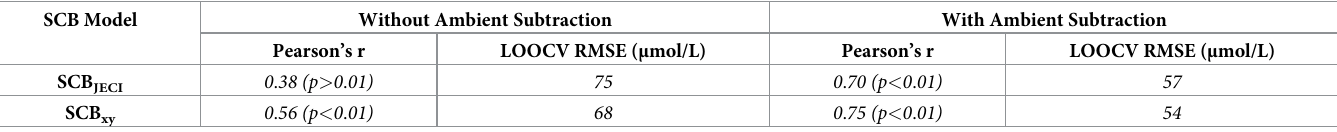
Table 1. Comparison of SCB models in terms of correlation with TSB and RMSE with/without ambient subtraction. SCB Model Without Ambient Subtraction With Ambient Subtraction Pearson’s r LOOCV RMSE ( μ